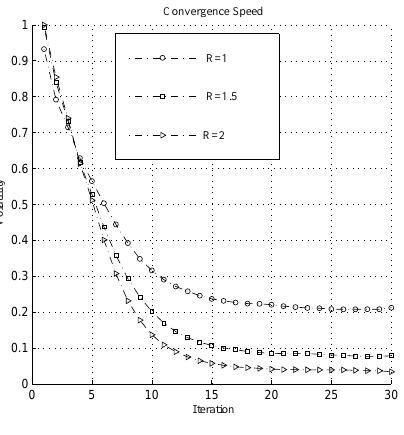
Figure 6. We have used 20 realizations for a observation window size of 500 for a network size of n = 100 and B = 4 numbers Figure 4. The simulation has run for the geometric graph. We of channel. Also the simulation has run for a constant range of assume a square area 100 units uniformly distributed random interaction on a random geometric graph to make the analysis configuration of n = 100 secondary users. We consider different independent of range of communication ranges R . For example R = 1 means that for a secondary node i all other nodes within an Euclidean distance of R = 1 are considered to be the neighbors N . It shows well i connected graphs have higher convergence speed.